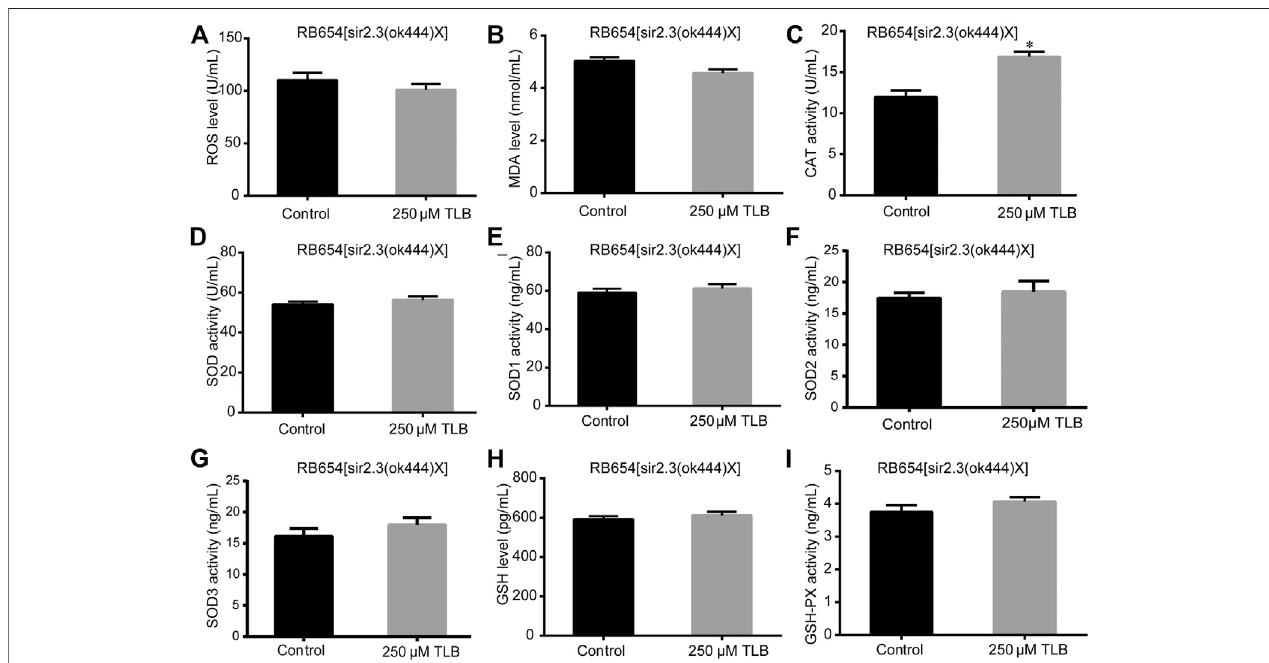
FIGURE6| Anti-oxidant effectsofTLB inSir2.3 mutant C.elegans . C.elegans were raisedinthe absenceorpresence of250 μ M TLBfor72 h.The totalprotein of C. elegans was extracted and centrifuged for 10 min at 10,000 × g, 4 ° C, then the supernatant was detected using appropriate ELISA kits. (A) ROS level; (B) MDA level; (C) CATactivity; (D) SODactivity; (E) SOD1activity; (F) SOD2activity; (G) SOD3activity; (H) GSHactivity; (I) GSH-Pxactivity. n (cid:2) 1000.Datawerepresented asmean ± SEM. * p < 0.05 vs. non-TLB treated